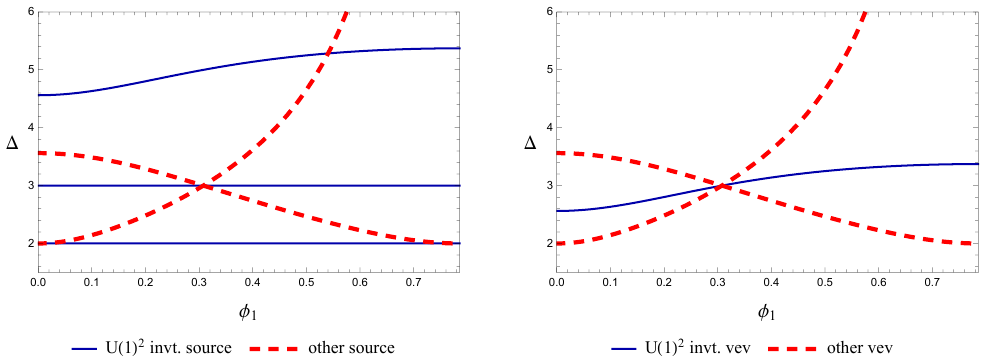
Figure 6 . Dimensions of BPS modes as we move on the conformal manifold (6.2), labelled by the value of φ 1 , and we have only shown φ 1 ≥ 0 . The N = 2 SU(2) × U(1) invariant S-fold is located at φ 1 = 0 and the N = 4 S-fold is located at φ 1 = arccos (1 / 3) / 4 ∼ 0 . 31 . The left plot gives the dimensions of operators which admit BPS sources, and the right those which admit BPS vevs. The blue curves are the BPS modes in the U(1) × U(1) invariant truncation and the red dashed curves are the remaining modes in the 10-scalar